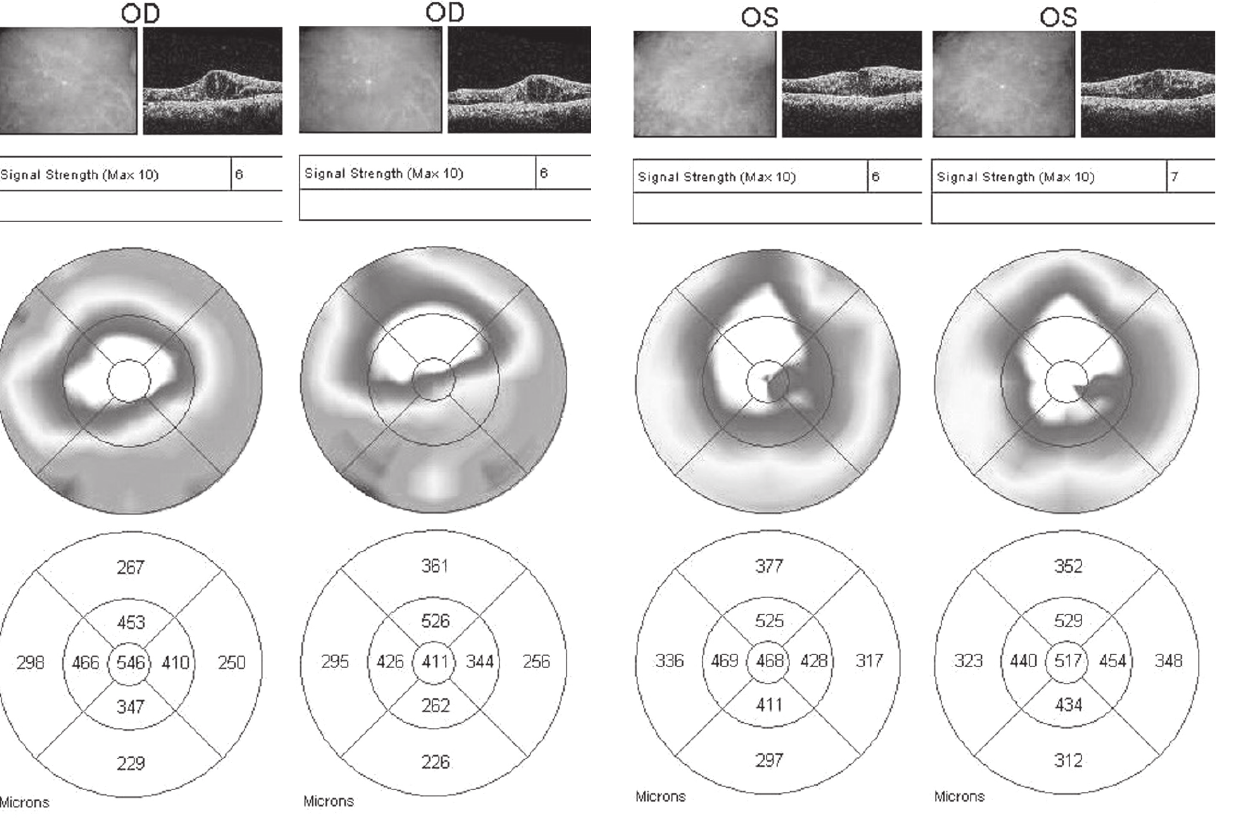
Figure 2 - Fast macular scans of a patient with diffuse diabetic macular edema obtained consecutively. Despite the smaller difference than observed in figure 1, there is still a reasonable amount of variation in central